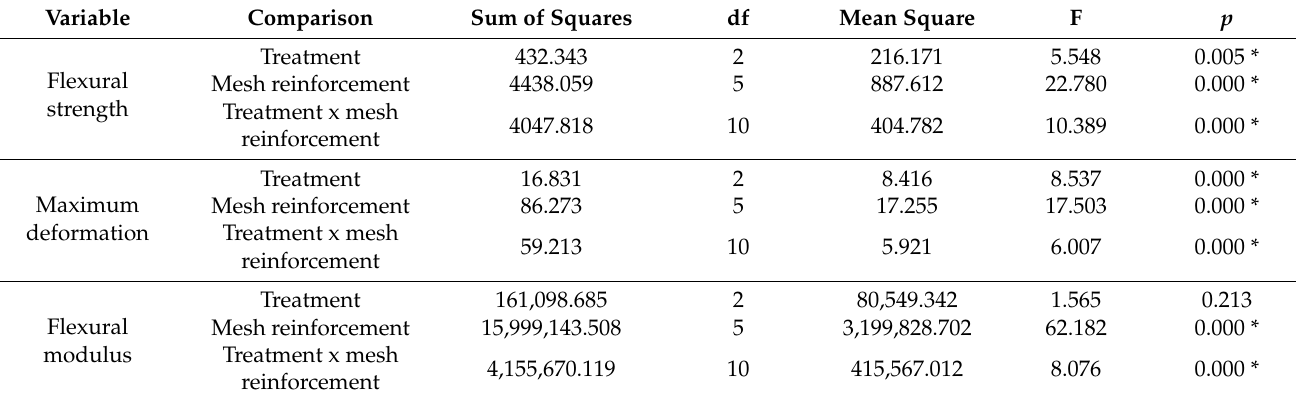
Table 2. Test results for between-subject effects obtained by two-way ANOVA